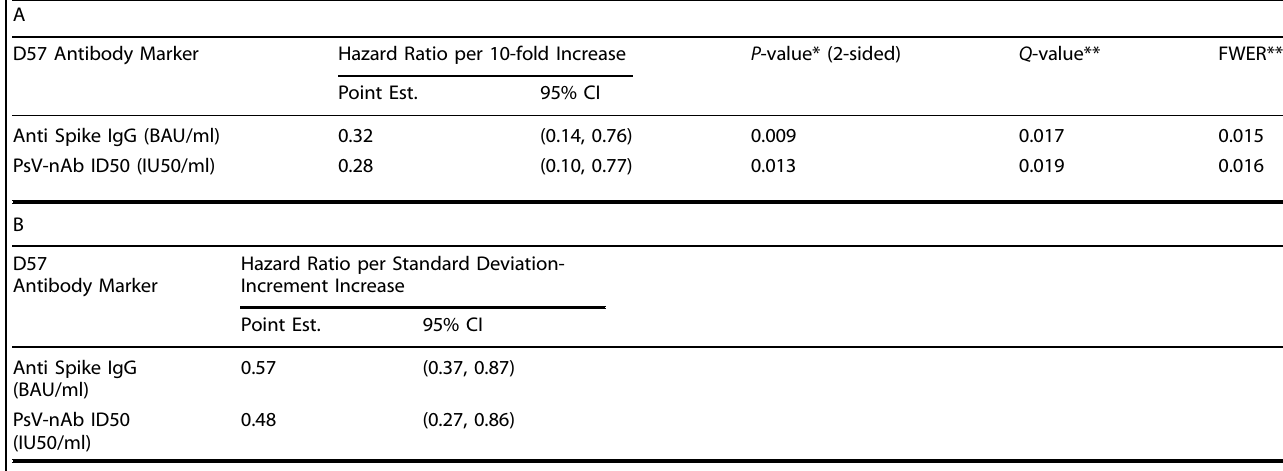
Table 2. Hazard ratios of COVID-19 (A) per 10-fold increase or (B) per standard deviation increase in each D57 marker in baseline negative vaccine